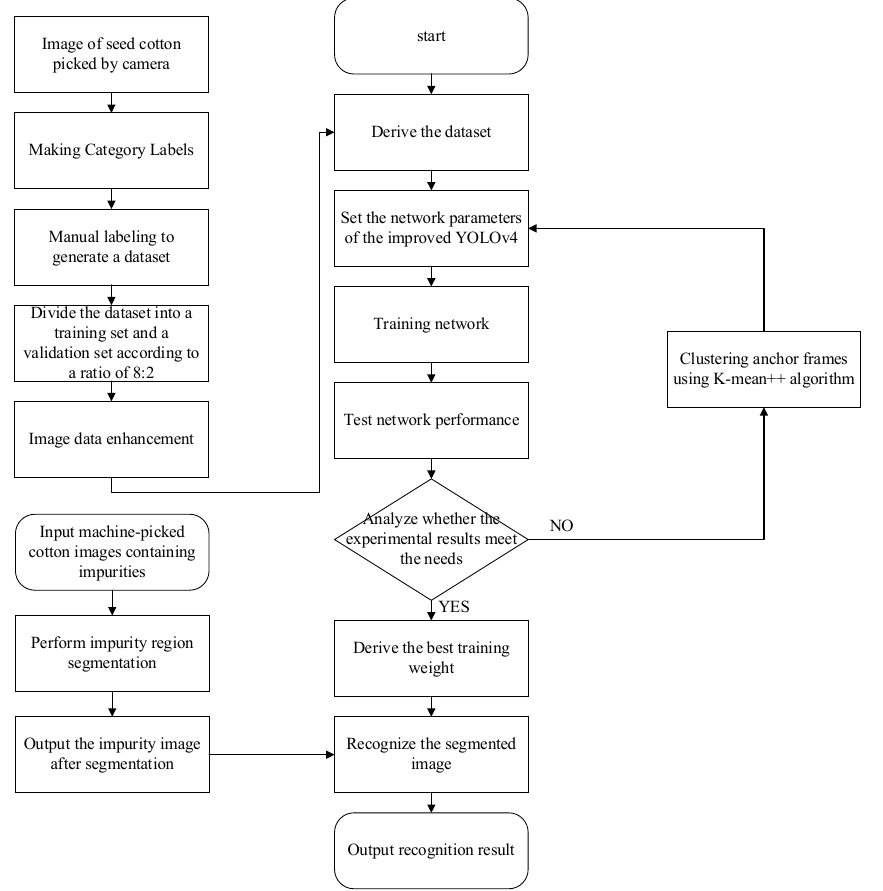
Figure 8. Flow chart of the impurity classification and recognition algorithm.